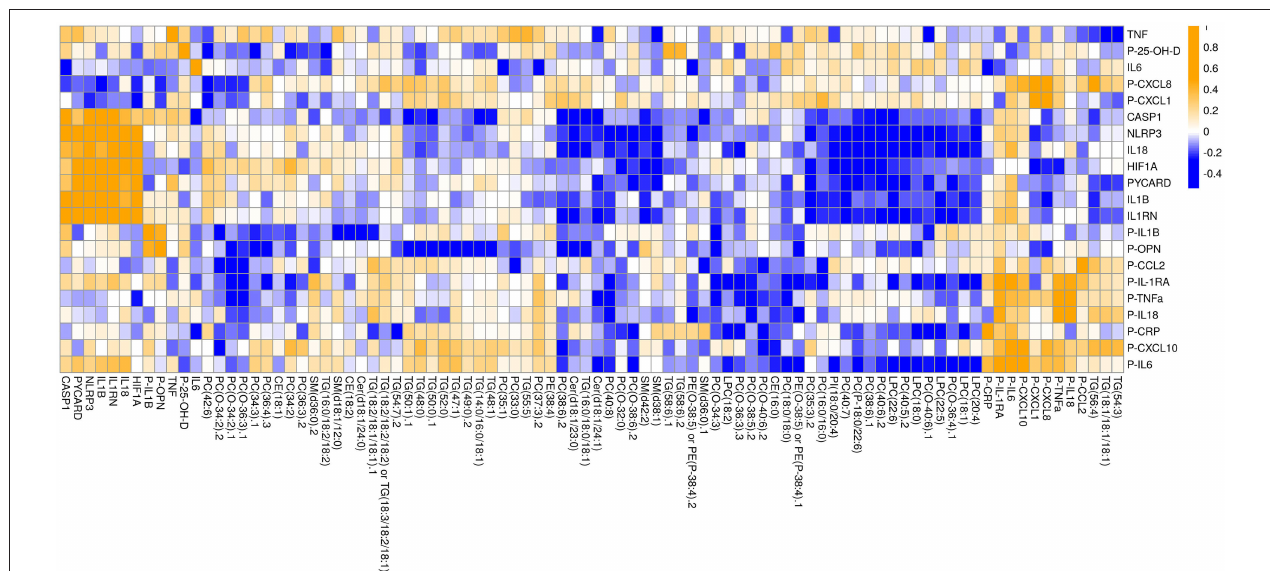
FIGURE 3 | Inflammatory-mediator-centric heatmap of significant ( p < 0.05 in ANOVA/TukeyHSD analyses) associations between inflammatory mediator and lipids, as measured by qPCR, electrochemiluminescent multiplex assay and UHPLC-QTOFMS. Lipid-lipid interactions were pruned from the original list of associations by assigning all lipid-lipid interactions with an NRR of 1. Circulating cytokines are indicated with P. Orange colour denote positive correlation and blue colour denotes negative